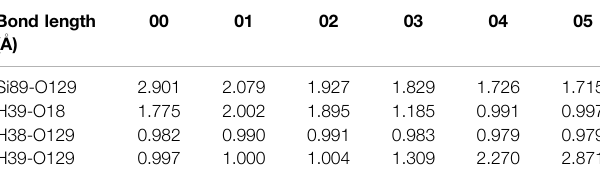
TABLE 1 | Changes in bond length for the reaction of H 2 O and P b0 defect. Bond length ( (cid:1) A)